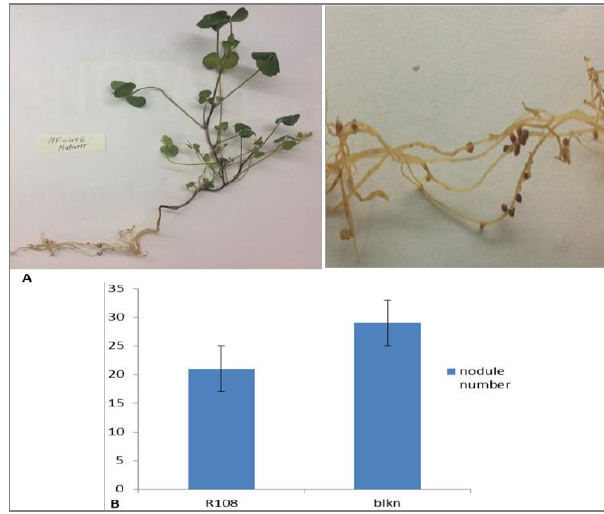
Figure 2 . (2A) one month-old blkn seedling showing black color nodule in a cluster arrangement. (2B) the average nodules number of blkn mutant was significally more than R108 wild type at p =0.03. Transfer sections of blkn nodule were compared to those of R108 through light microscopy examination.